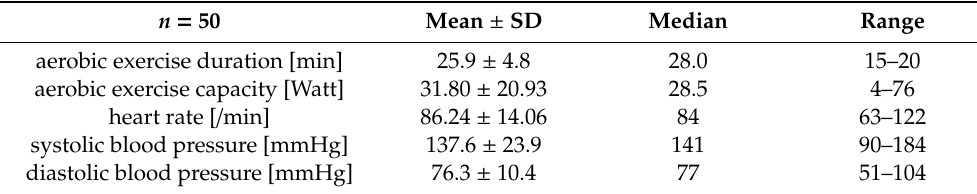
Table 2. Parameters during aerobic exercise cardiopulmonary exercise testing